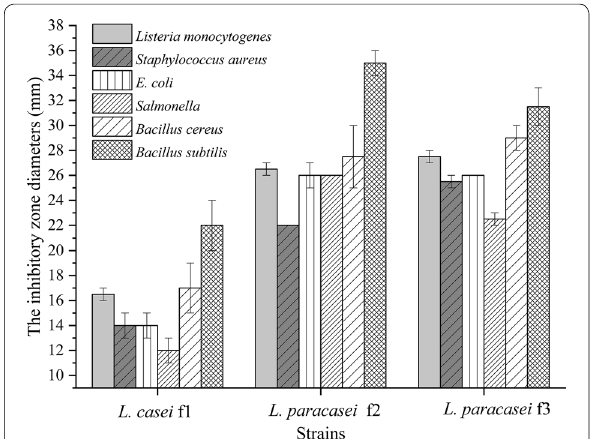
Fig. 6 The antimicrobial activity of L. casei f1, L. paracasei f2 and L. paracasei f3. Six common intestinal pathogens were used as indicator bacteria and the diameter of inhibition zones were measured. Data are presented as mean SD (n 3). The vertical bar represents ± = standard errors of